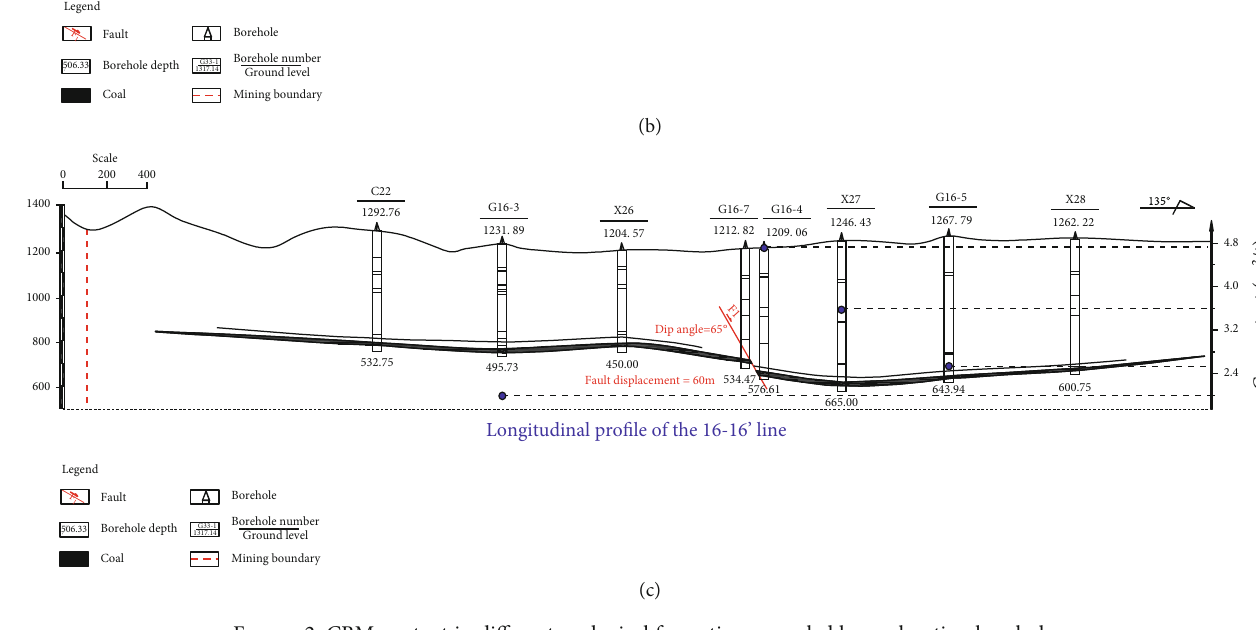
Figure 2: CBM content in di ff erent geological formations revealed by exploration